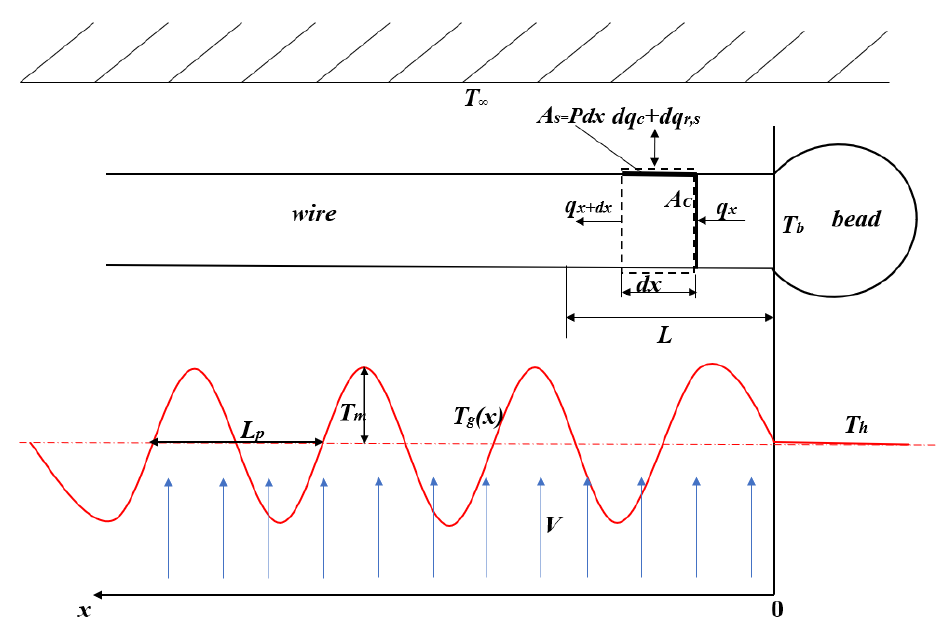
Figure 4. Energy balance of thermocouple wire fin.